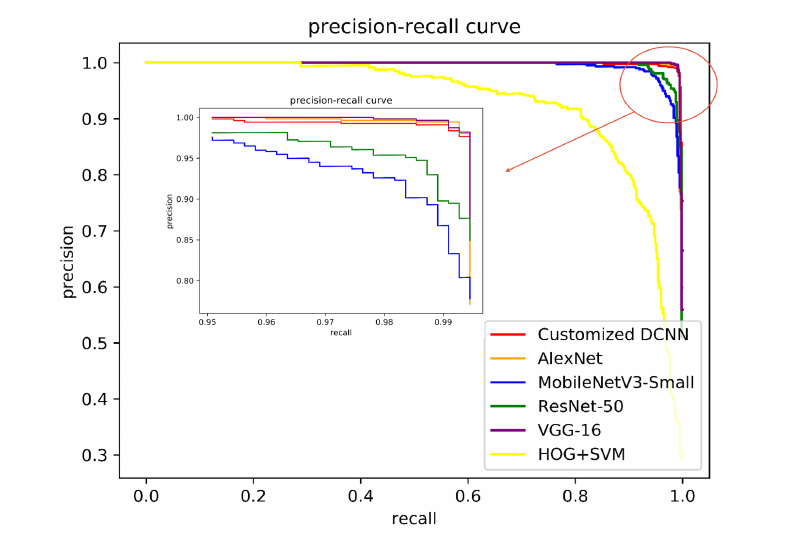
Figure 14. Precision-recall curves of different methods for parking slot occupancy classification. Table 7. Performance of parking slot occupancy classification of different methods in the self-annotated testing